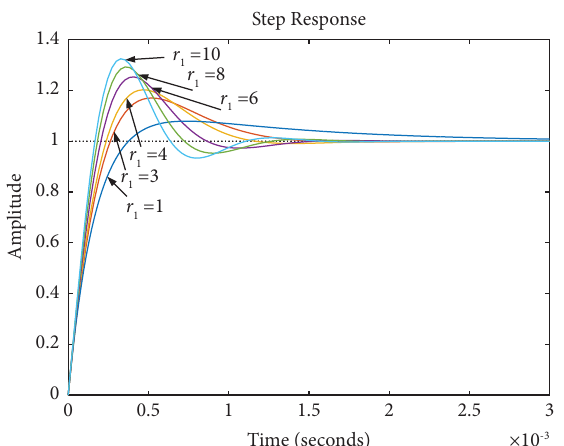
Figure 5: Step responses of closed-loop G ( s ) when r 10 .